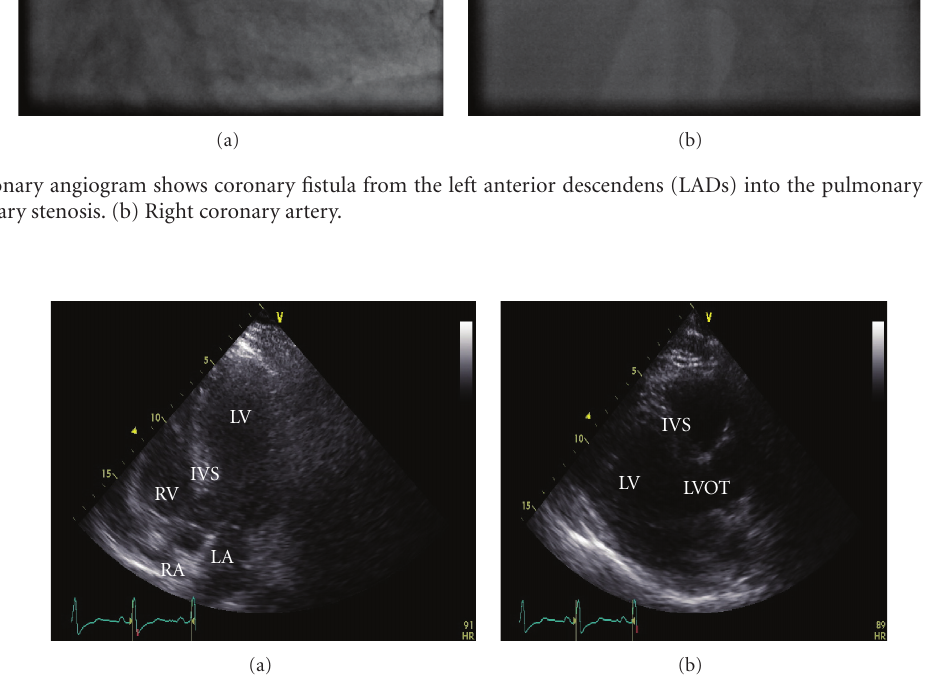
Figure 3: Apical four-chamber view (a) and parasternal long axis view (b) with poor acoustic window revealed thickened left ventricular walls. LV: left ventricle; LA: left atrium; LVOT: left ventricular outflow tract; RV: right ventricle; RA: right atrium; IVS: interventricular